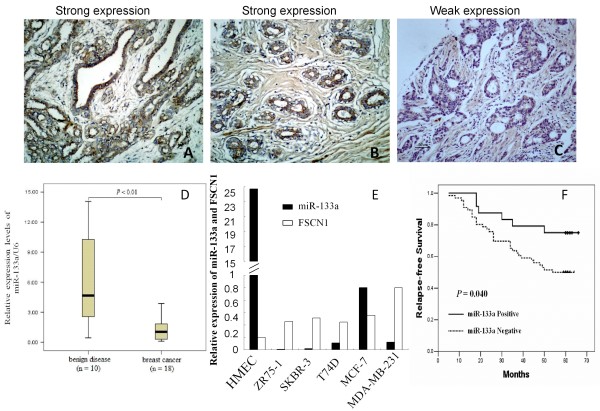
Expression of miR-133a in breast tissue specimens and cell lines. A. Strongly positive expression of miR-133a in tissues of breast benign disease. Magnification: ×200. B. Strongly positive expression of miR-133a in an adjacent normal breast tissue. Magnification: ×200. C. Weakly positive expression of miR-133a in an invasive ductal carcinoma. Magnification: ×200. D. Fresh tissue samples from patients with breast cancer or benign breast diseases were obtained from the surgery room. Total miRNA was extracted from the tissues and subjected to qRT-PCR analysis. E. Expression of miR-133a and FSCN1 in breast cancer cell lines: Breast cell lines were grown in monolayer for 3-5 days, and miRNA and total RNA was extracted and subjected to qRT-PCR analyses. F. Association of miR-133a expression with relapse-free survival of the patients with breast cancer.